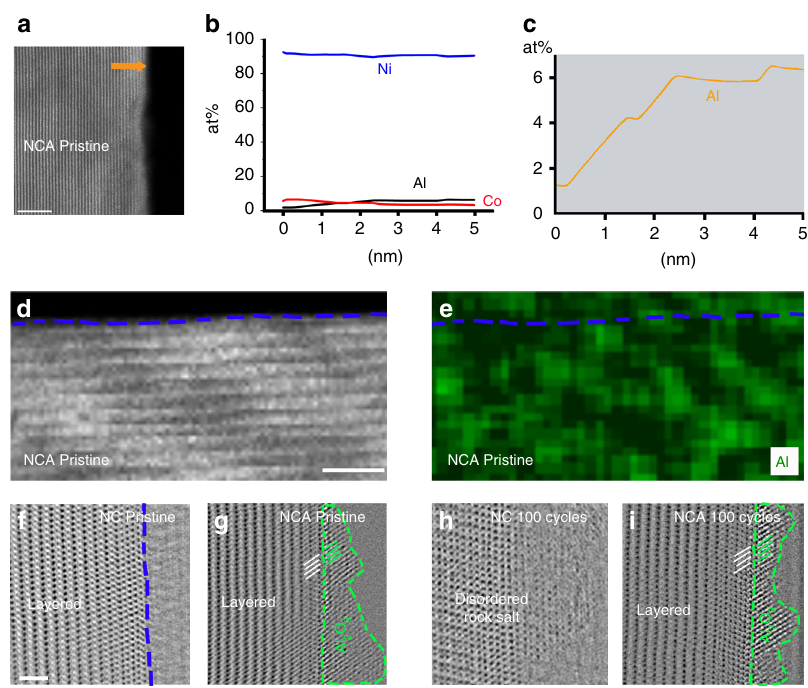
Fig. 3 Spatial distribution of Al in NCA. a STEM-HAADF image of pristine NCA. b Atomic compositional pro fi le of Ni, Co, and Al along the arrow in a . c The enlarged view of Al compositional pro fi le, indicating enrichment of Al on the surfaces. HAADF-STEM image d and corresponding EDS mapping e of pristine NCA sample. The blue dashed lines represent the surface boundary of NCA primary particle, and the green color depicts the Al elements distribution. f , h The ABF images of pristine and 100 cycled NC surfaces, respectively. The blue dashed lines depict the boundary of NC surfaces. g , i The ABF images of pristine and 100 cycled NCA surfaces, respectively. The green dashed lines outline the Al 2 O 3 phase. The white and green lines represent the (01 (cid:1) 2) planes of parent phase and ( (cid:1) 120) planes of Al 2 O 3 phase, respectively. Scale bar, 5 nm ( a , d ), 1 nm ( f